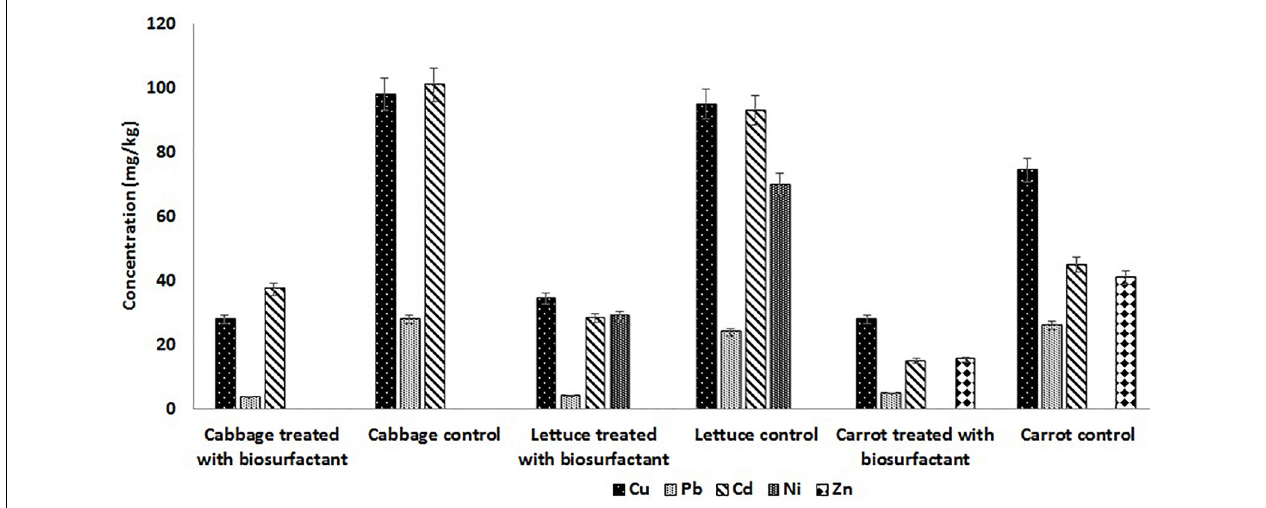
FIGURE 8 | MSI 54 lipopeptide in surface treatment of vegetables showed heavy metal remediation in the vegetables treated with MSI 54.